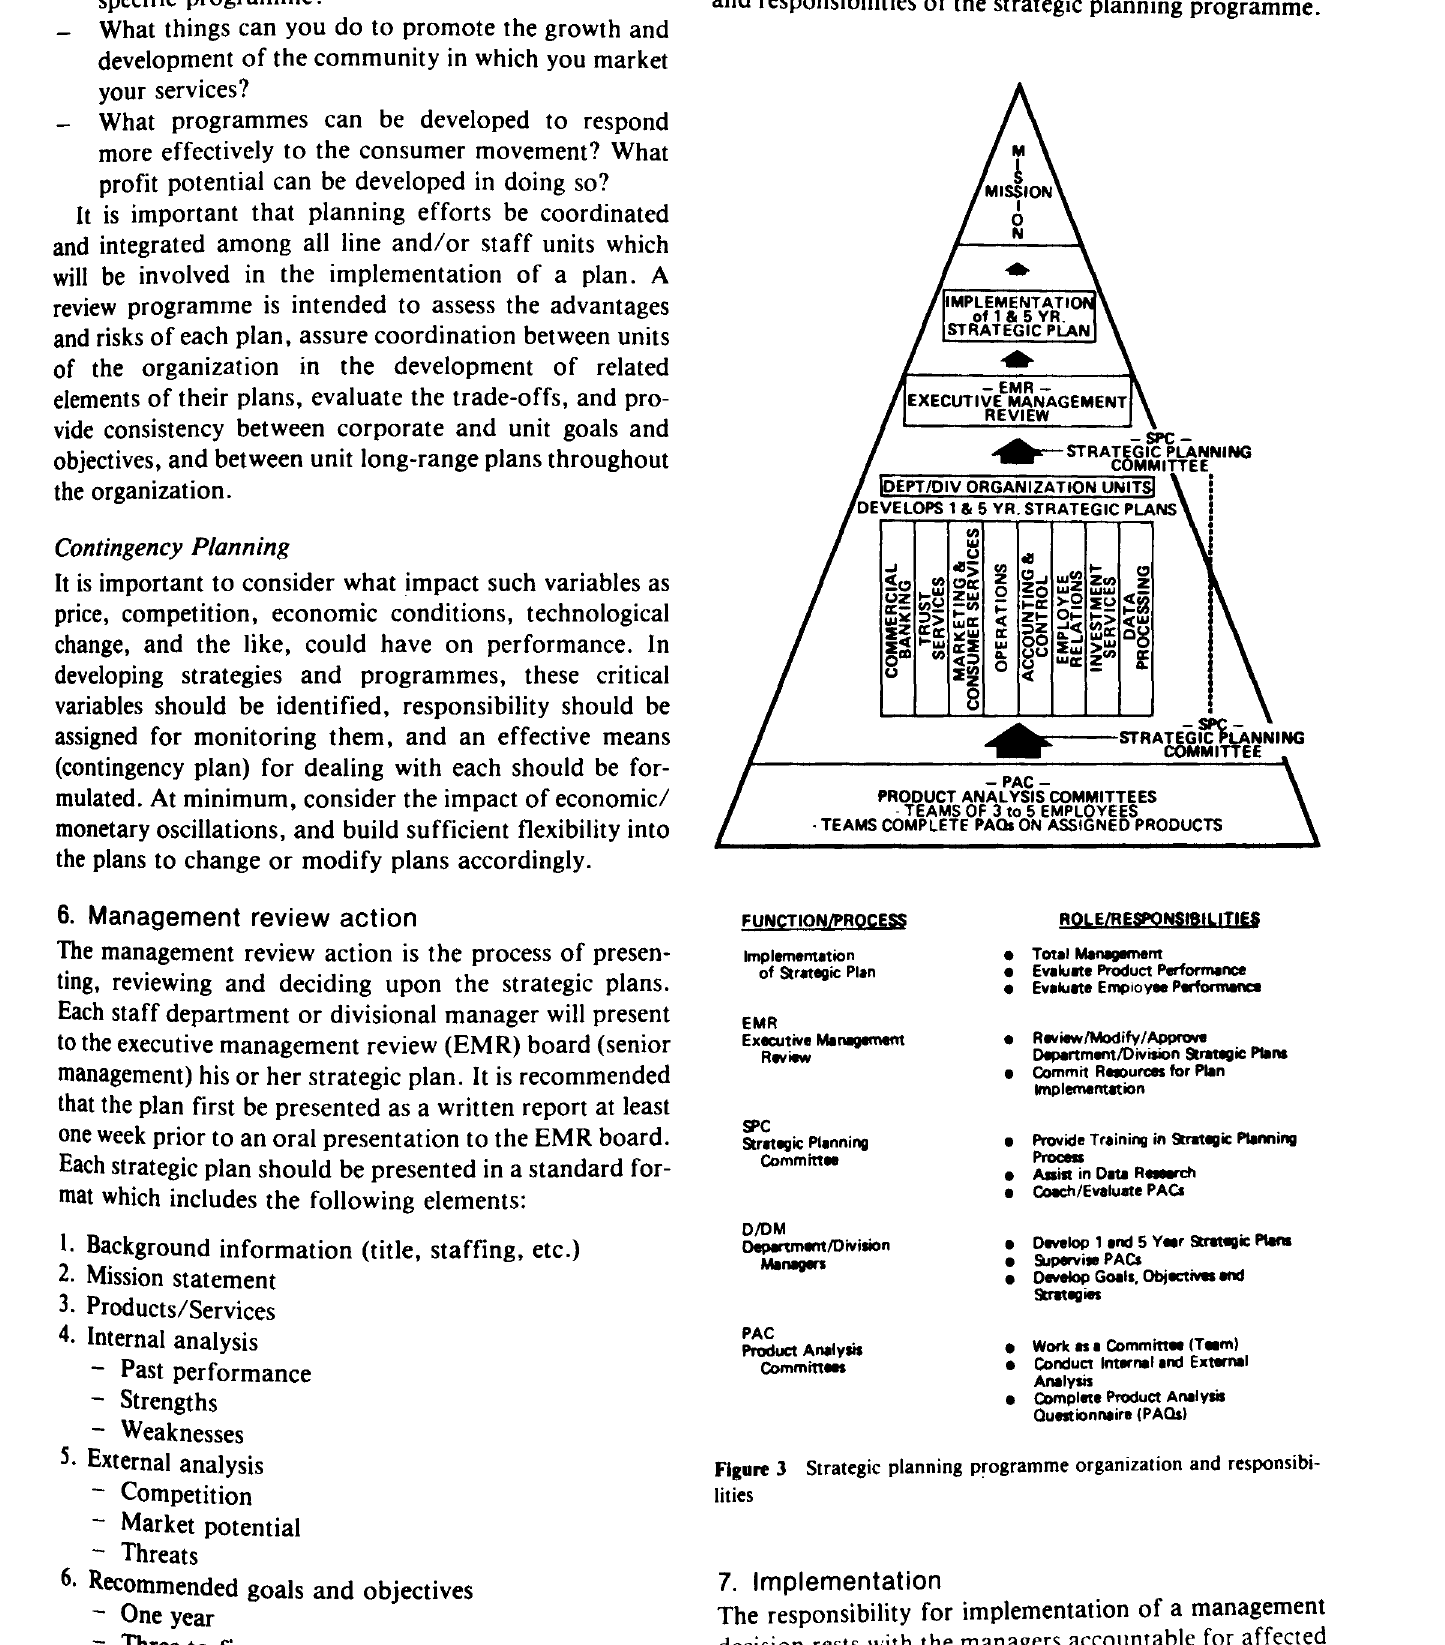
Figure 3 Strategic planning programme organization and responsibi